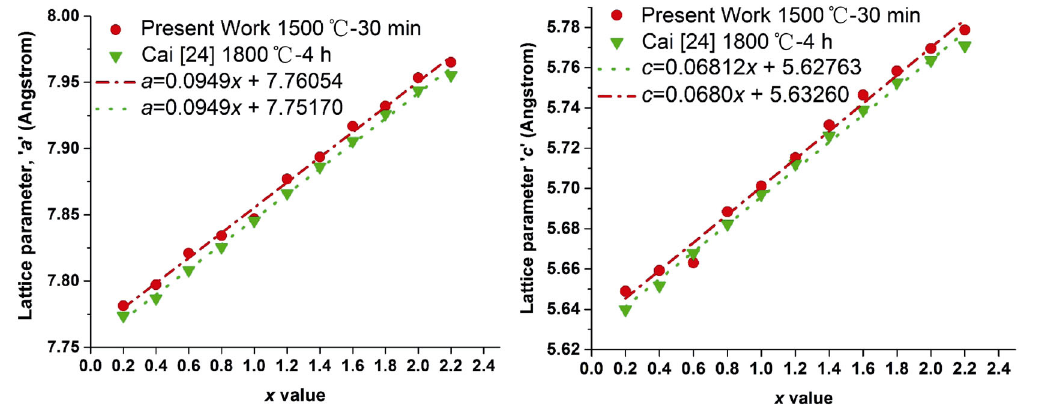
Fig. 6 Variation of lattice parameters of calcium stabilized nitrogen rich α-sialons with x value for samples synthesized at 1500 ℃ using SPS and those reported by Cai [24] at 1800 ℃ using